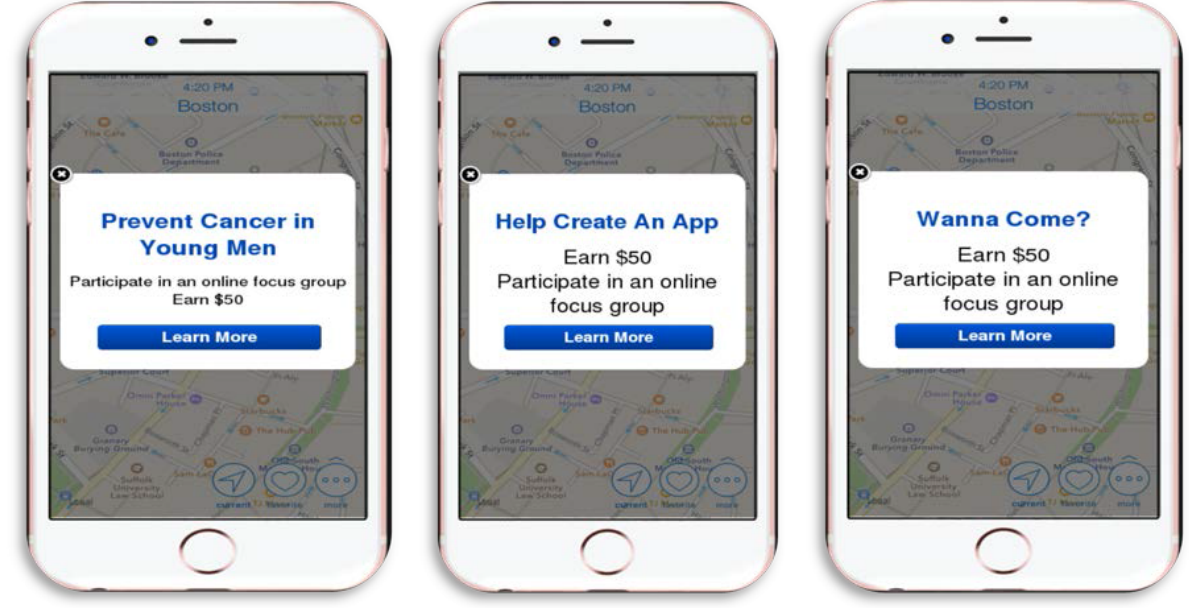
Figure 1. A total of 3 study advertisements with different text-based